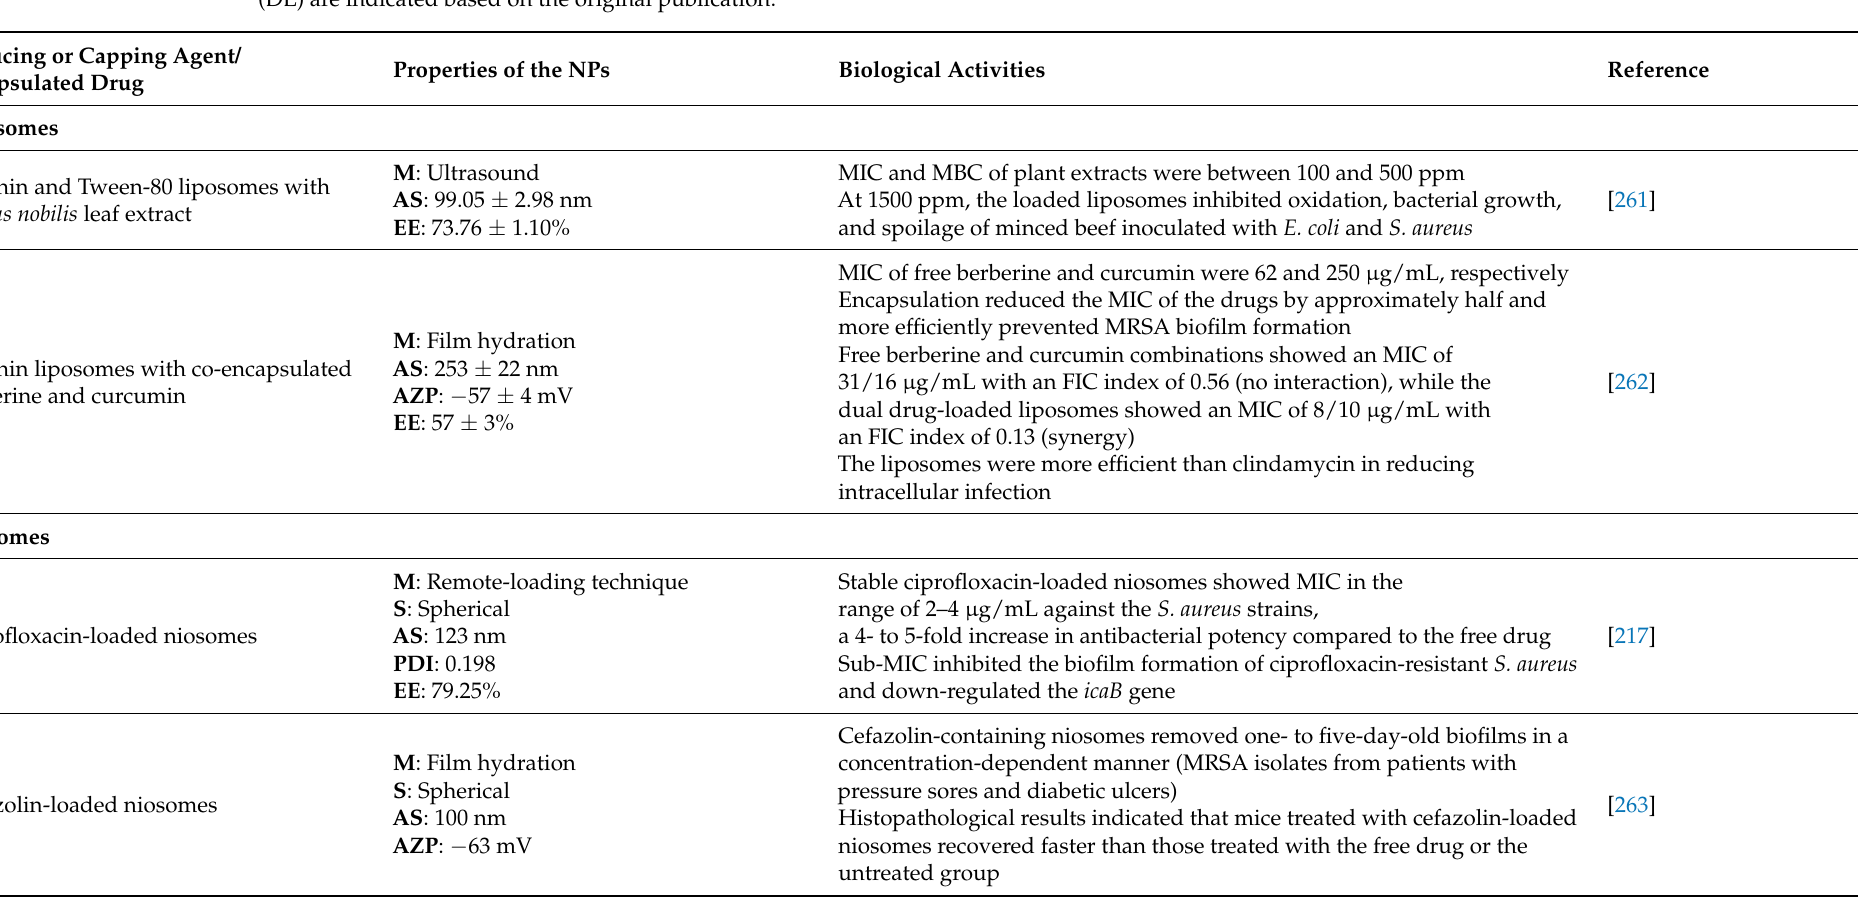
Table 4. Recent studies on controlling Staphylococcus aureus growth and biofilm formation using different types of organic nanoparticles (NPs). The method of preparation (M), shape (S), average/particular size (AS), zeta potential (AZP), polydispersity index (PDI), encapsulation efficiency (EE), and drug loading capacity (DL) are indicated based on the original